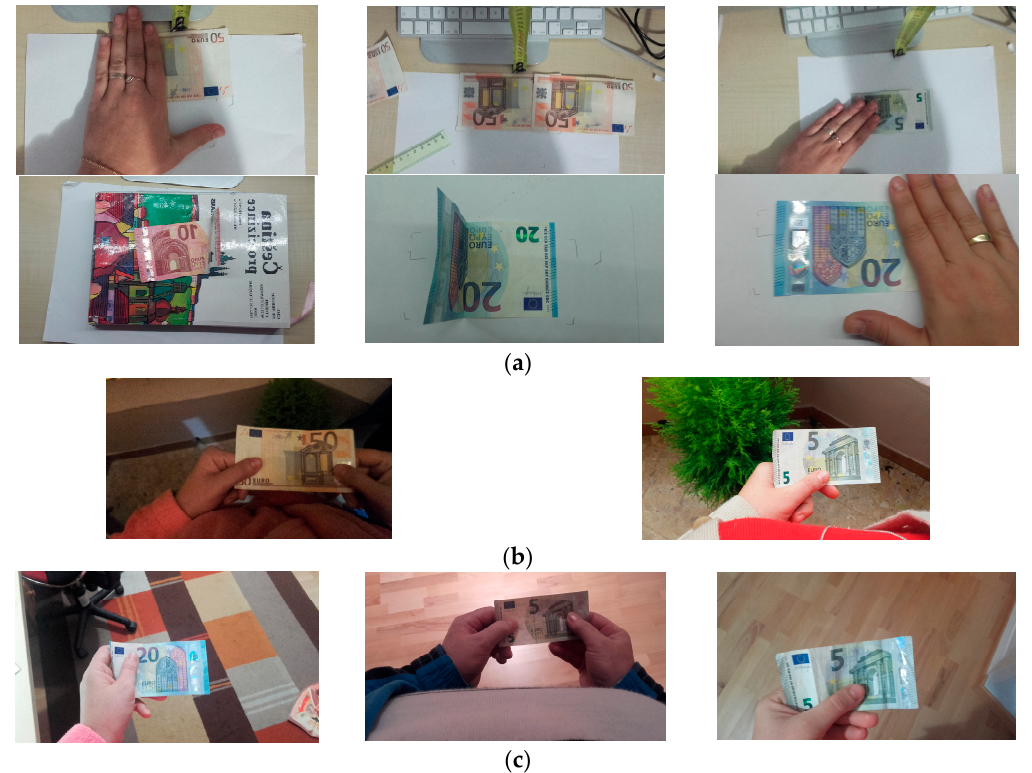
Figure 10. Folded and covered Euro banknotes in indoor and outdoor environment cases used in trials: ( a ) Cases where real banknotes are on the table; ( b ) Real banknotes held by the users—in this case, the environment is an open environment, both night and day; ( c ) The banknotes are held by the user in an enclosed environment (at home and in a shop with artificial illumination).